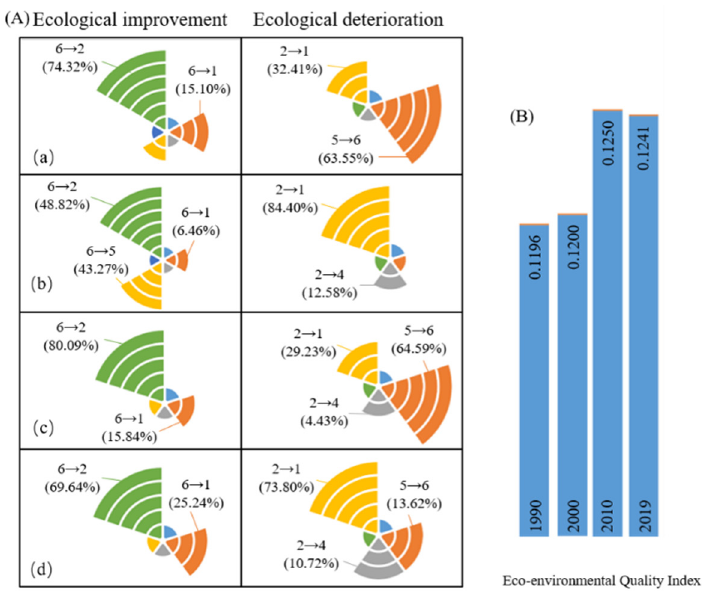
Figure 7. Ecological contribution of the Tarim River Basin (1990–2019). ( A ) Contribution rate of land conversion among different land types to ecological environment: ( a ) 1990–2000; ( b ) 2000–2010; ( c ) 2010–2019; and ( d ) 1990–2019 (1. cropland; 2. grassland; 3. woodland; 4. built-up land; 5. water bodies; and 6. barren land). ( B ) Eco-environment quality index of the Tarim River Basin (1990–2019).